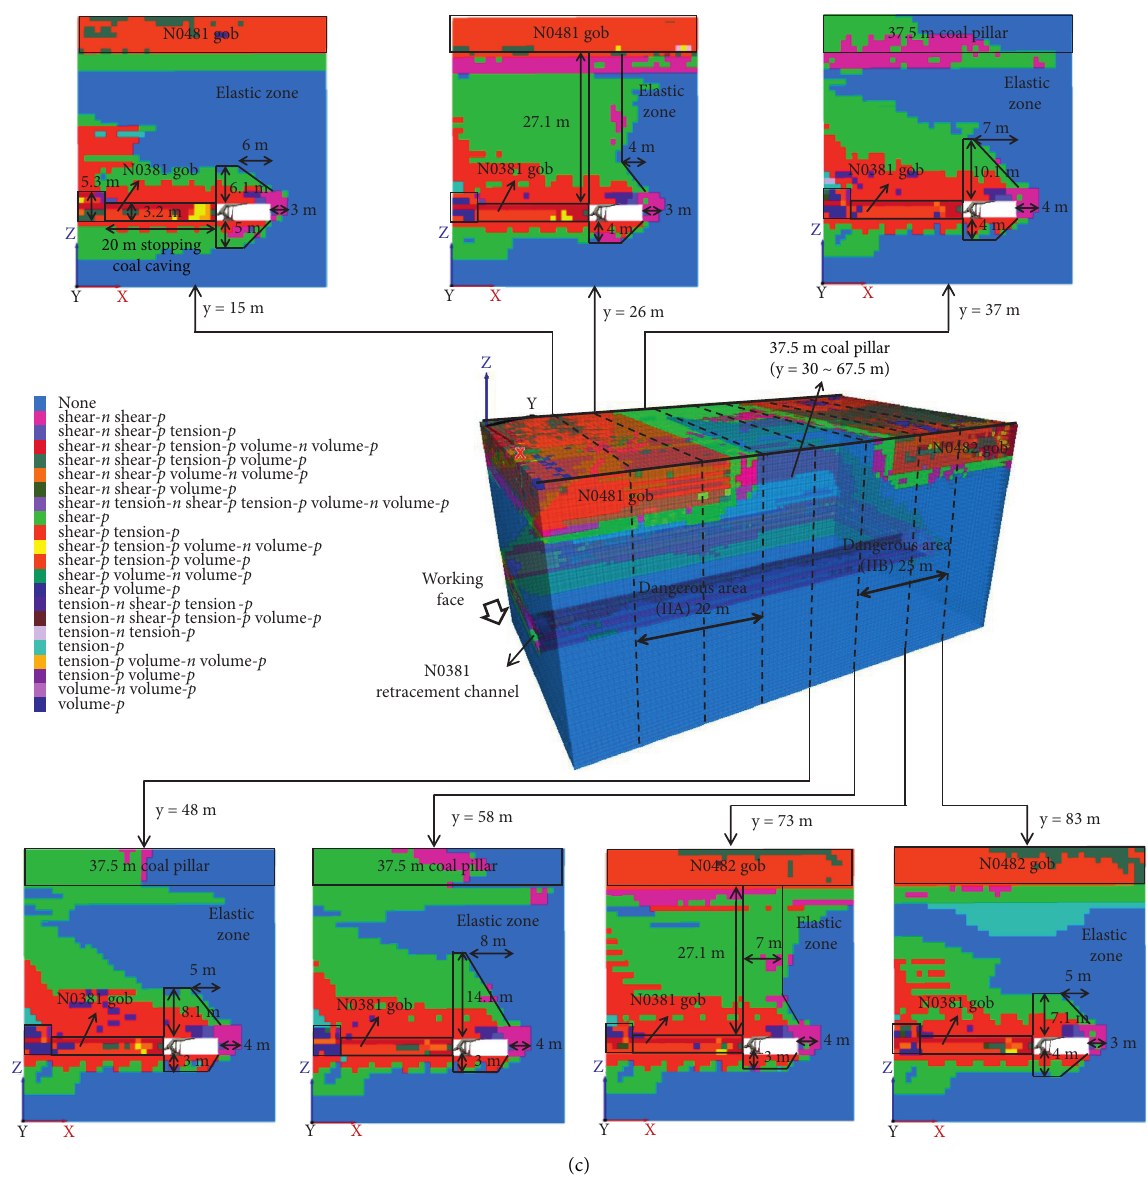
Figure 13: Characteristics of plastic failure of N0381 retracement channel. (a) Upper coal-pillar aspect ratio of 1. (b) Upper coal-pillar aspect ratio of 2. (c) Upper coal-pillar aspect ratio of